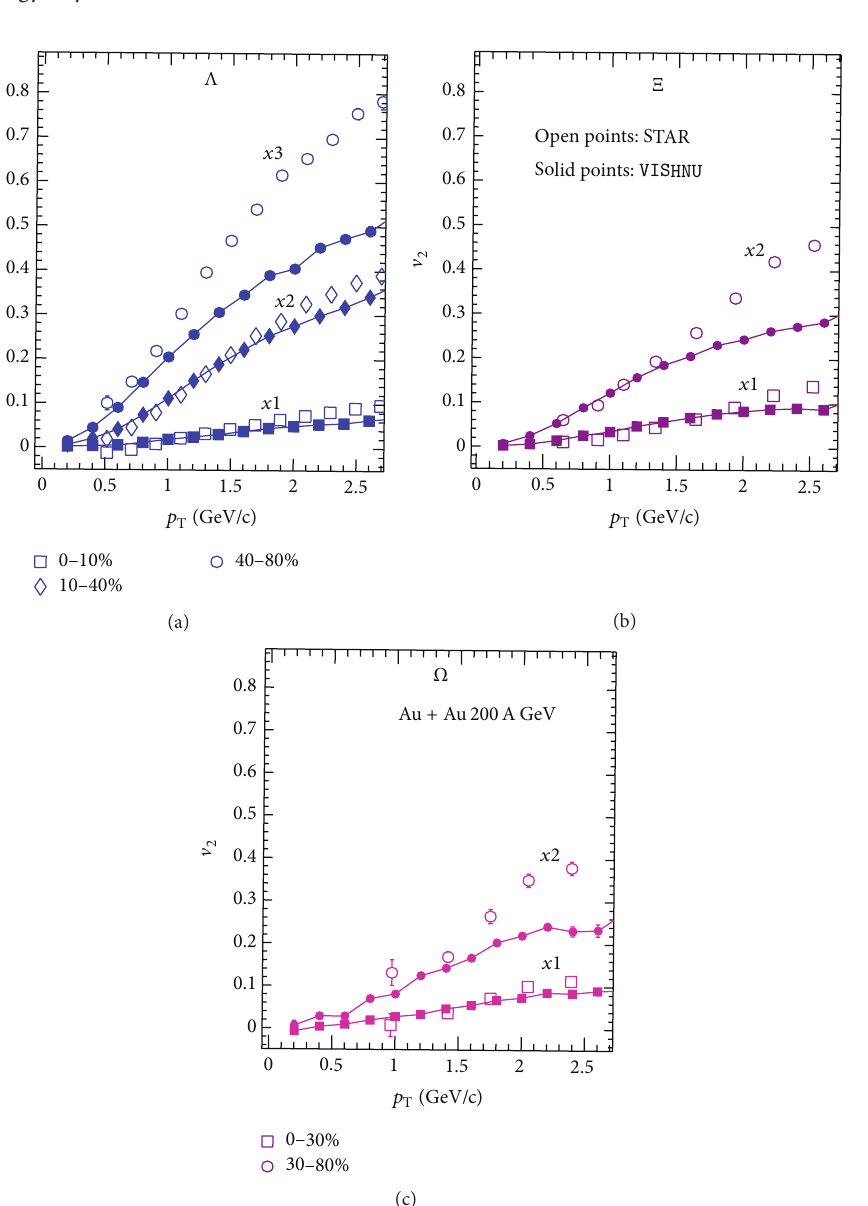
Figure 3: Differential elliptic flow of strange hadrons Λ (a) at centralities of 0–10% (squares), 10–40% (diamonds), and 40–80% (circles), and multistrange hadrons Ξ (b) and Ω (c) at centralities of 0–30% (squares) and 30–80% (circles) in Au + Au collisions at √𝑠 NN = 200 GeV. Experimental data (open points) are from STAR [19, 20]. Theoretical results (solid points) are calculated from the VISHNU viscous hydrodynamics hybrid model with the inputs presented in Section